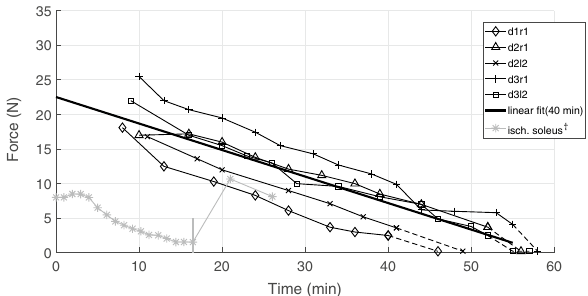
Figure 1. Decline of isometric muscle force ( F ) at TD versus time after muscle extraction. Only trials with TD force of at least 95% of its isometric value (converged force before or after TD) were included. The solid line 0 . † The measured isometric force in cat is a linear fit to all data points below 40 min extrapolated back to t = m. soleus in response to induced ischaemia from Mortimer et al. 17 . In the shown trial, they stimulated the cat muscle with single twitches ( ) under ischaemic conditions, whereafter blood flow was returned (grey, vertical ∗ > 20 min). In a similar study, the isometric force in rabbit m. line at 16.5 min mark) to recover muscle force ( ∗ anterior tibialis recovered 87 % of the measured maximal isometric force after 1 h of ischaemia 18